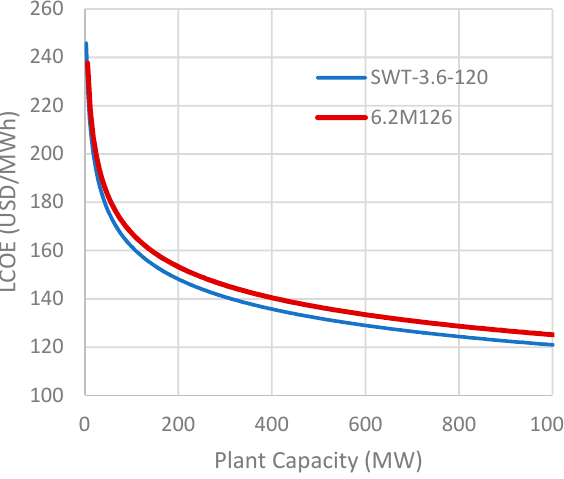
Figure 29. LCOE comparison of SWT-3.6-120 and 6.2M126 vs. plant capacity.